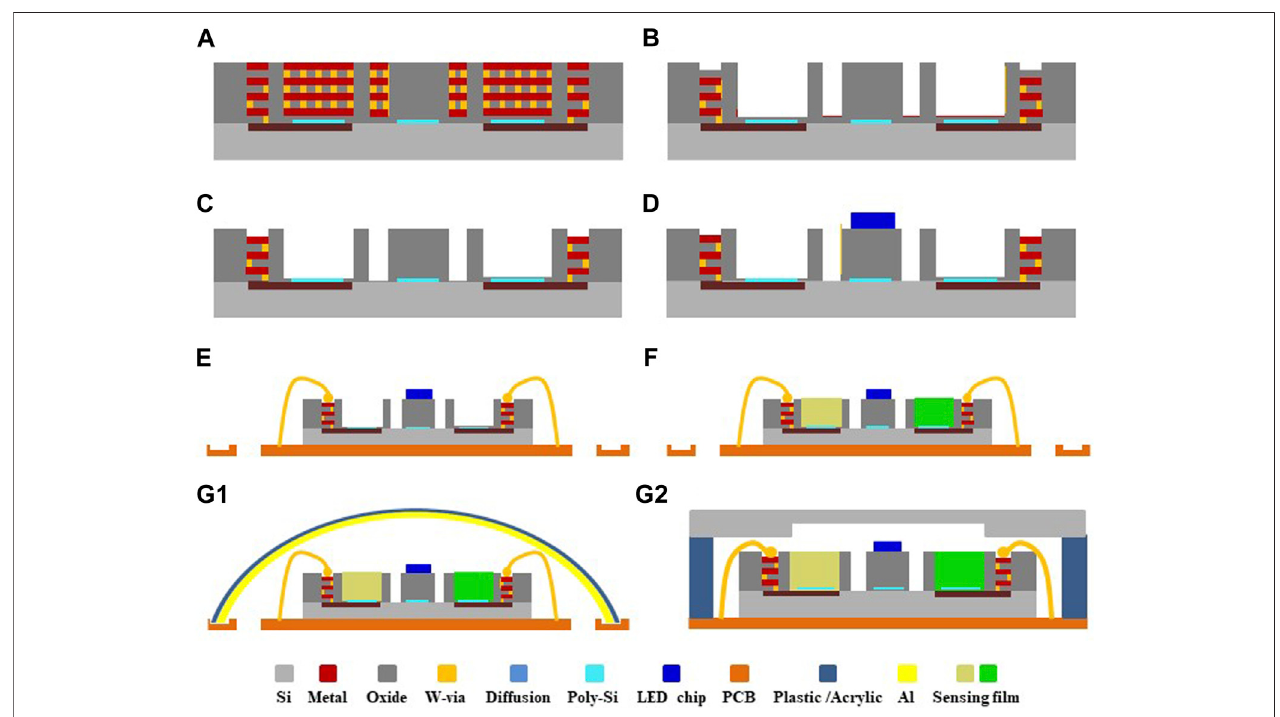
FIGURE 3 | Fabrication process steps: (A) CMOS chip fabricated by the TSMC, (B) metal wet etching to de fi ne structures on the sensing chip, (C) RIE etching to remove the dielectric layer to open bonding pads for wire bonding, (D) assembly of the blue LED chip on the CMOS-MEMS chip, (E) wire bonding between the CMOS- MEMS chip and the PCB board, (F) dispensing of gas sensing fi lms, and (G) bonding of light re fl ectors to cover the CMOS-MEMS chip.